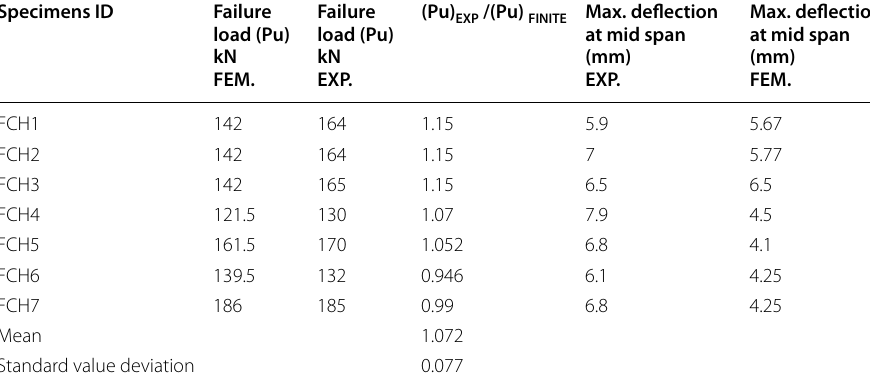
Table 3 Experimental and finite element